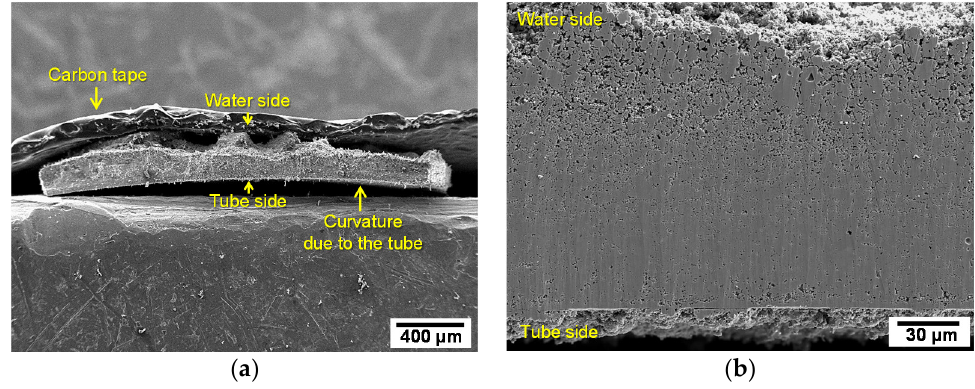
Figure 1. SEM micrographs of SG flakes: ( a ) overall appearance and ( b ) cross section of flake.